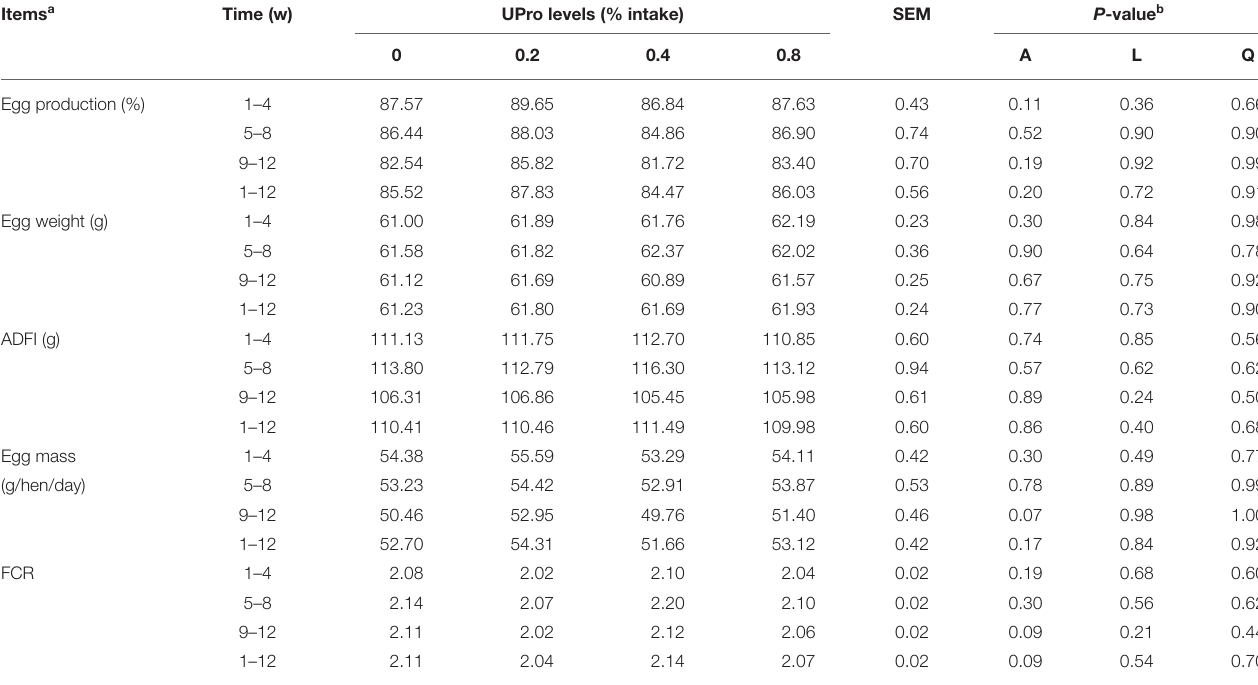
TABLE 3 | Effects of dietary UPro on production performance of laying